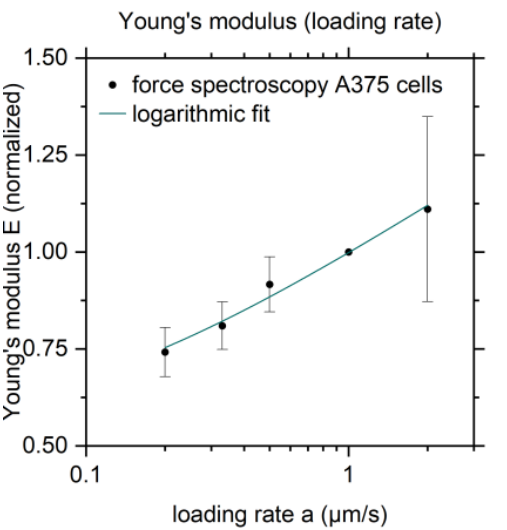
Figure 3. Young’ modulus E as a function of the loading rate normalized to the Young’s modulus Figure 3. Young ’ modulus E as a function of the loading rate normalized to the Young’s mo dulus from reference measurements with a loading rate a = 1.0 µ m/s. The logarithmic fit function is from reference measurements with a loading rate a = 1.0 µm/s. The logarithmic fit function is E = E = 0.98 + 0.19 ln (a + 0.98 + 0.19 ln (a + 0.1).